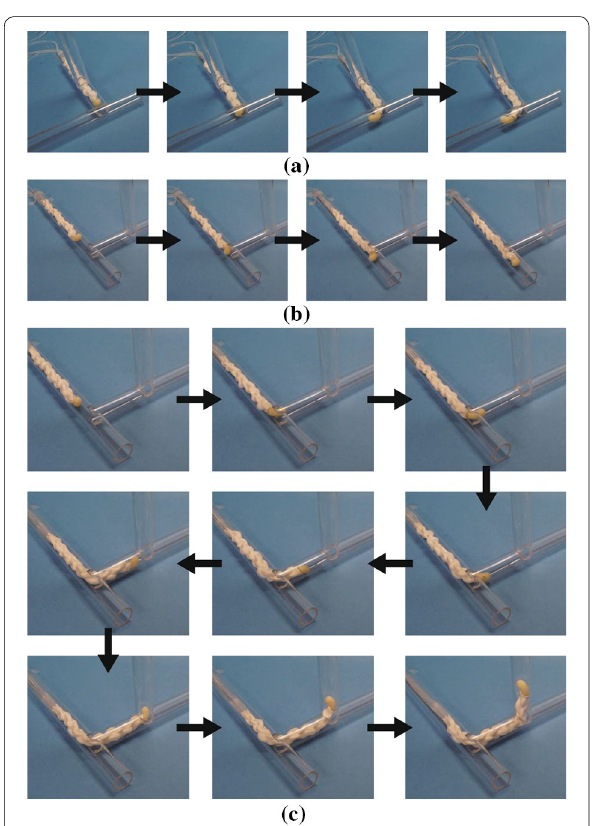
Fig. 15 Steering through the experimental piping system. A video of the experiment is available in Additional file 1. a Steering motion in an A-type branch (Path A in Fig. 12). b Straight locomotion in a B-type branch (Path B in Fig. 12). c Steering motion in skew branches (Path C in Fig. 12)